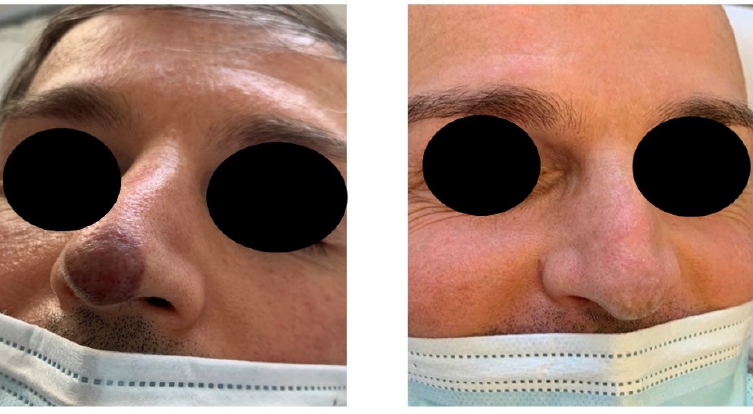
Figure 2. Patient with epidemic KS at T0 ( left ) and T5 ( right ).